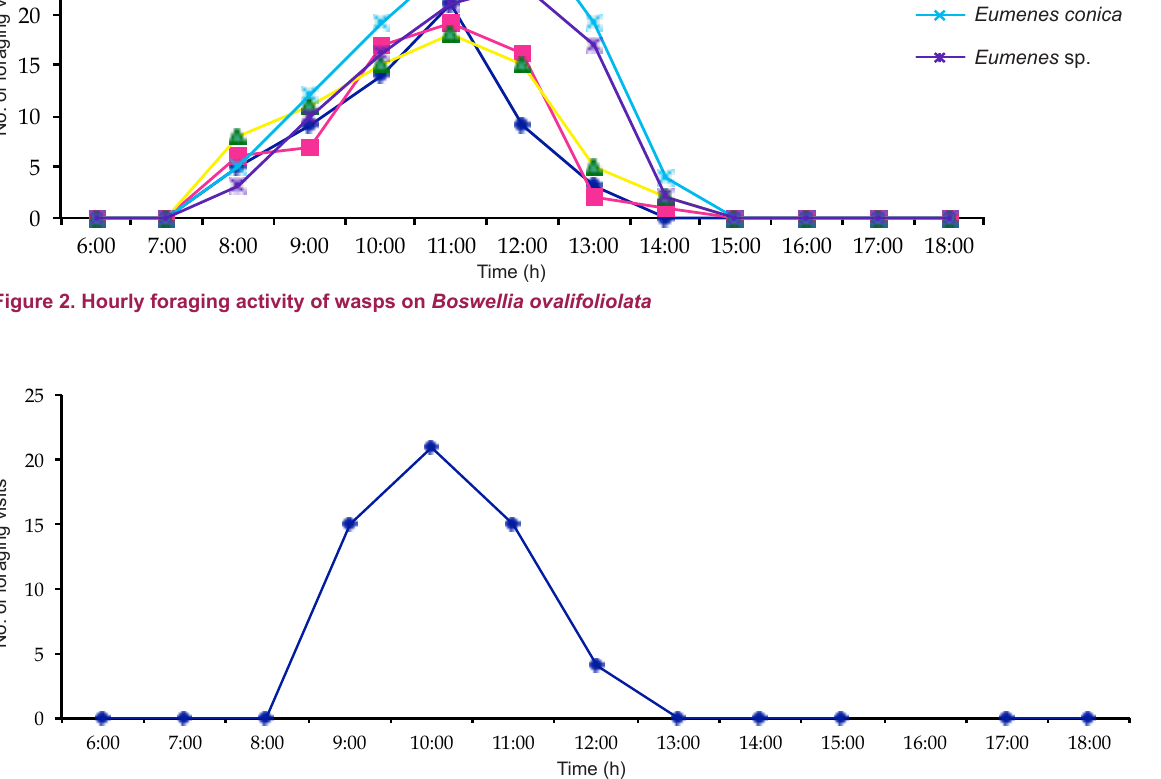
Figure 3. Hourly foraging activity of the Dipteran, Hyperalonia sp. on Boswellia